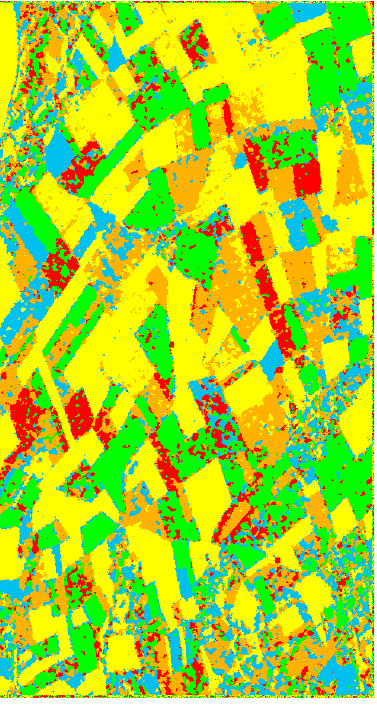
Figure 5. Pixel-based classification results of the Flevoland data. The first row shows the classification results, and the second row shows the corresponding classification results where the ground-truth map exists. ( a ) Wishart-MRF (WMRF). ( b ) K-Wishart-MRF (KMRF). ( c )